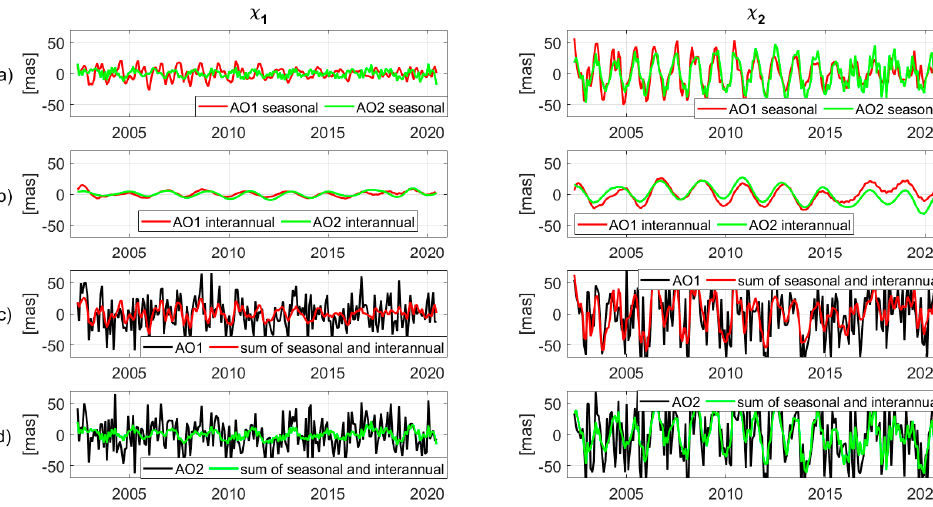
Figure 2. Monthly geophysical PM excitations (AO1, AO2) per reconstruction components (RCs) for χ 1 and χ 2 for ( a ) seasonal, ( b ) interannual intervals, plus ( c ) AO1 overall vs the sum of seasonal and interannual oscillations of AO1, ( d ) AO2 overall vs. the sum of seasonal and interannual oscillations of AO2 excitations.